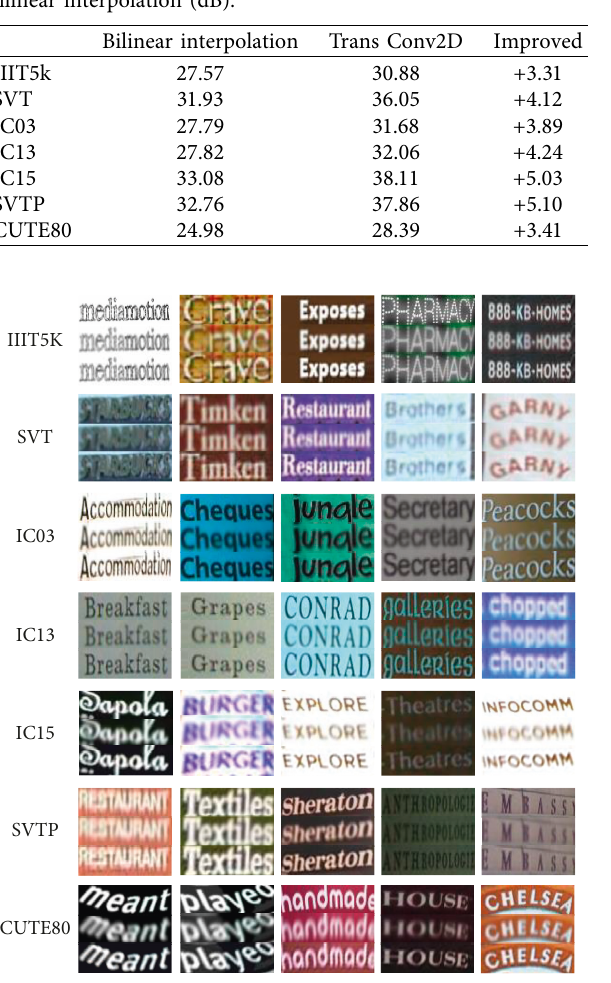
Figure 7: Performance of the adoption of Trans Conv2D in the super-resolution branch. In each image, from the top to bottom are the original image, blurred low-resolution image, and super-res- olution image,